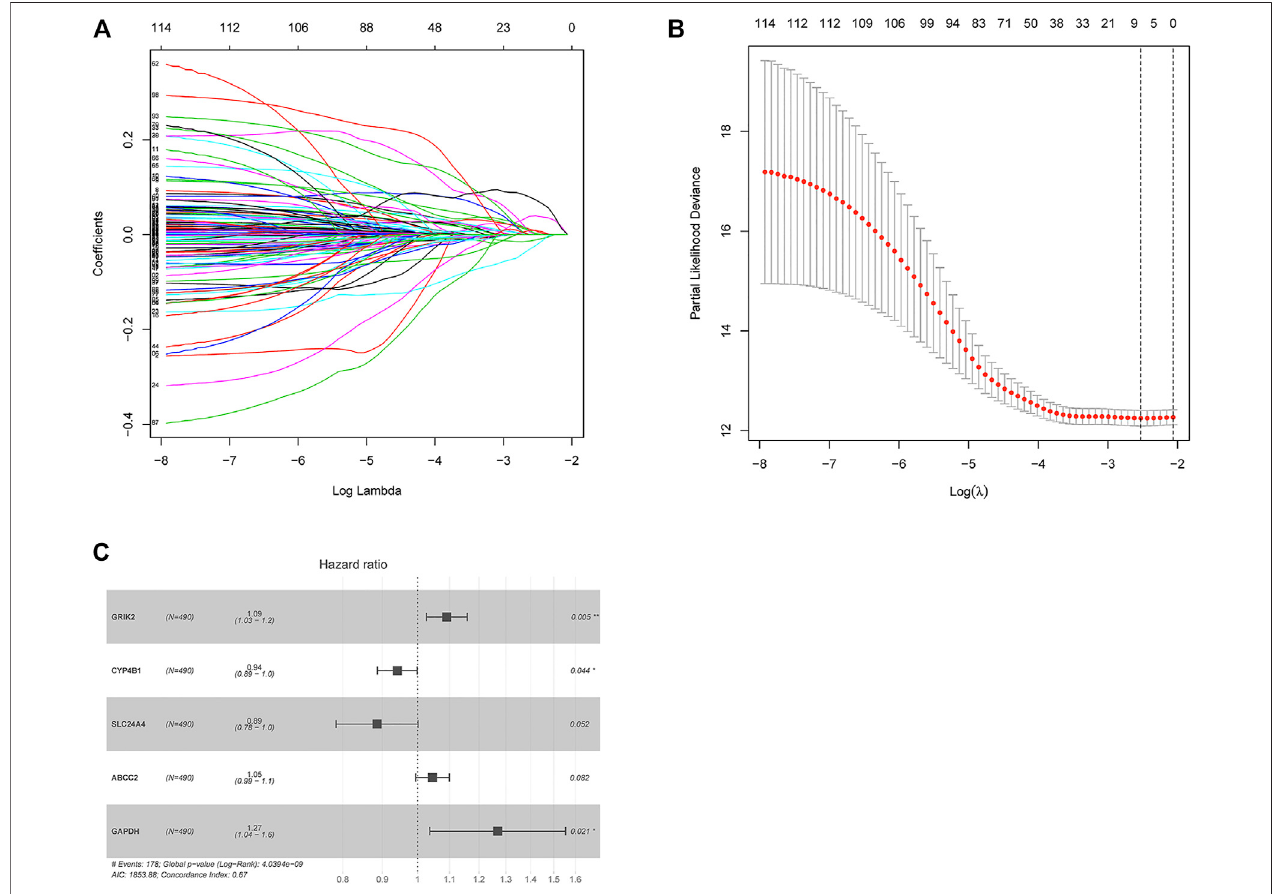
FIGURE 2 | Construction of a fi ve-gene based prognostic model. (A) The coef fi cients of 117 survival-related genes vary with the penalty parameter lambda in LASSO regression analysis. (B) Selection range of the optimal penalty parameter ( λ ) of LASSO COX regression model. The upper coordinate indicates the number of genes corresponding to different lambda values. (C) Forest plot of multivariate COX regression analysis. * p < 0.05. ** p <